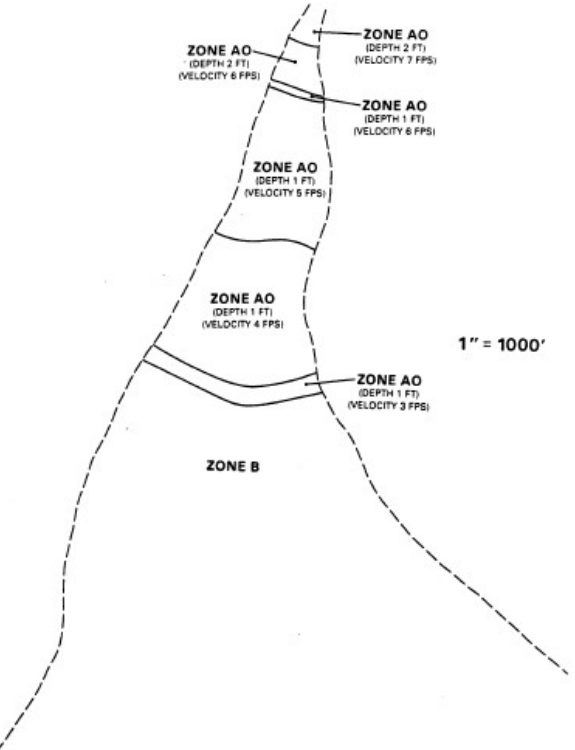
Figure 5. Examples of AO zones according to depth and velocity in the FAN model (Federal Emergency Management Agency and Federal Insurance Administration,